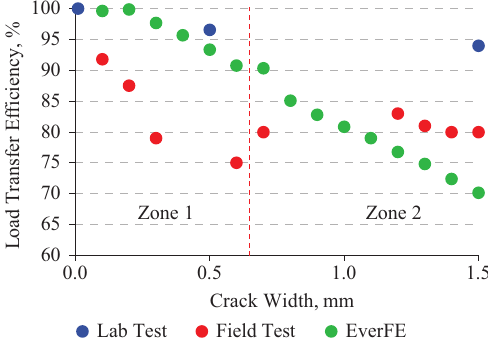
Figure 5. Relations Load Transfer Efficiency−Crack Width obtained from the field, laboratory tests and modelling with software